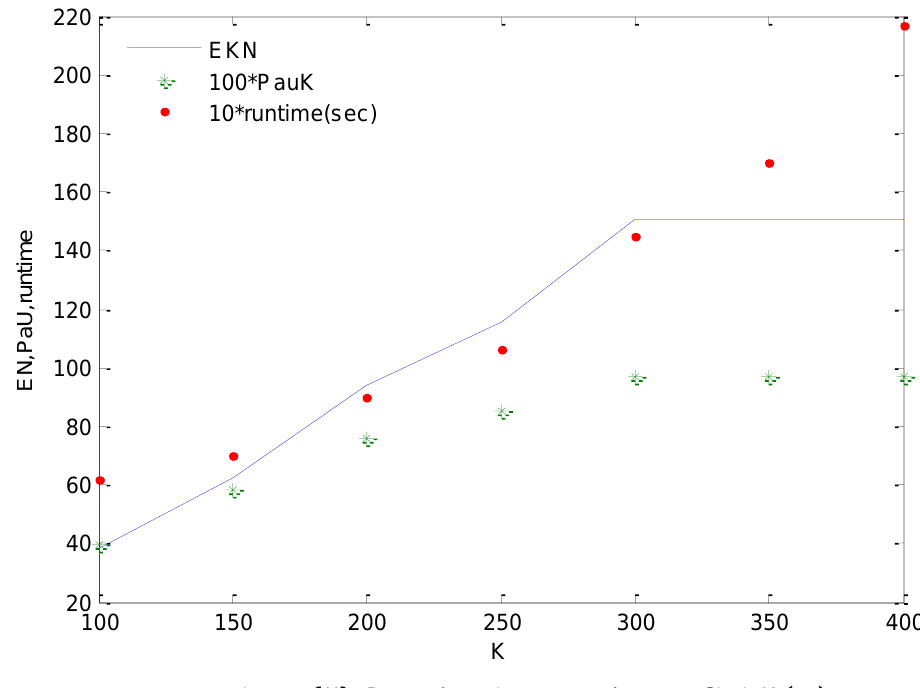
Fig. 3. E{ N }, P a,U and runtime versus the upper limit K (31):